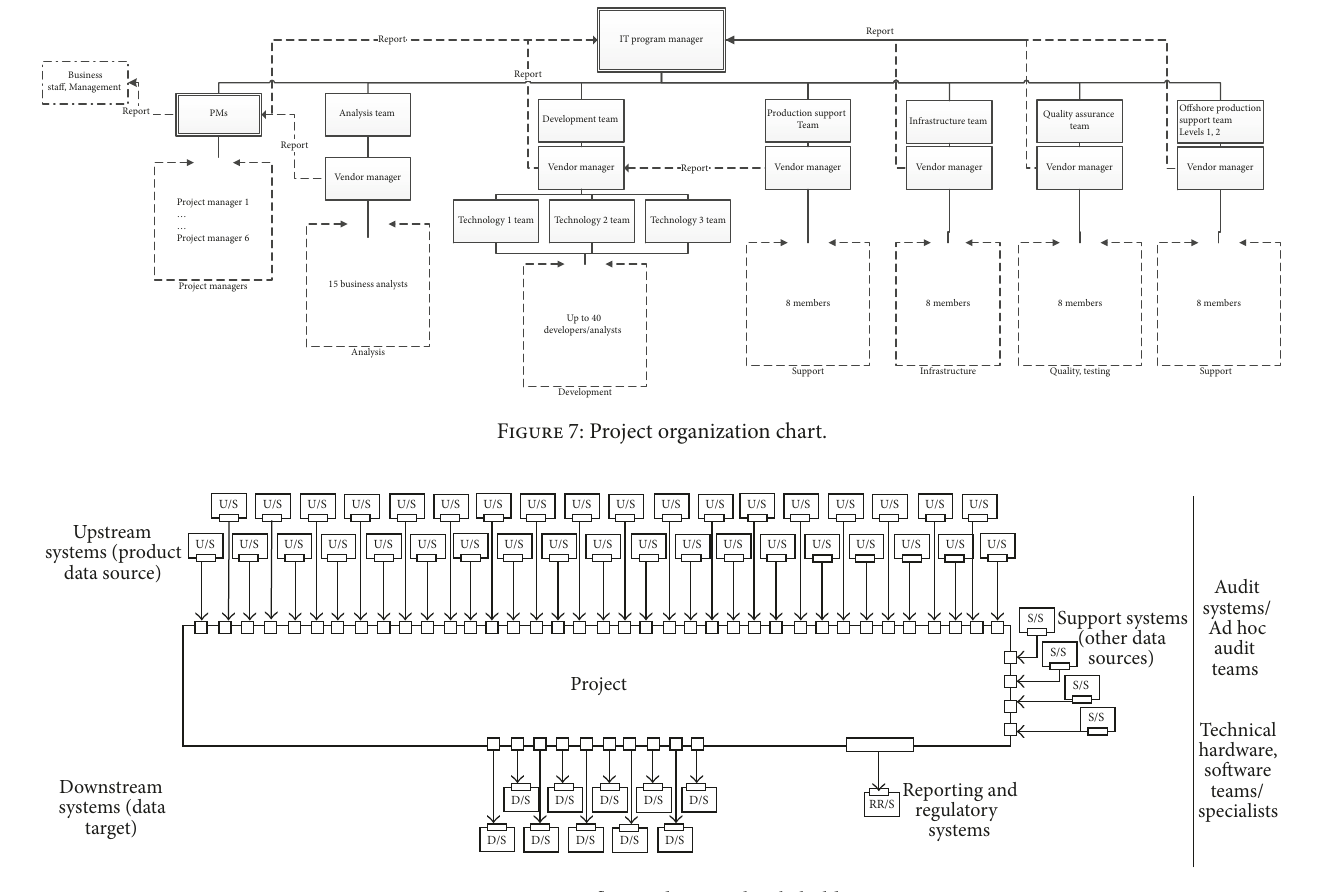
Figure 8: Data flow and external